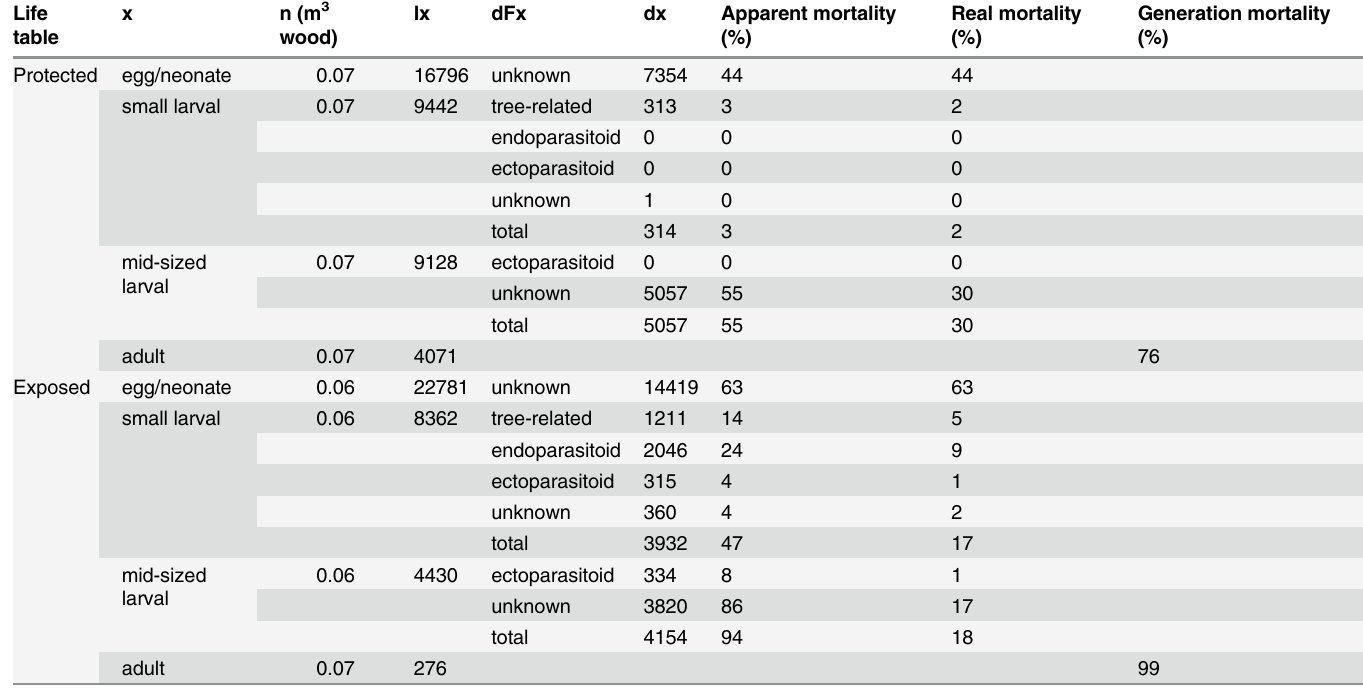
Table 3. Partial age-specific life tables (2013 – 2014), including mortality factors, from experimentally-established Sirex noctilio populations, which were protected from or exposed to the naturally-occurring community of associate insects and fungi in southern Ontario. Life